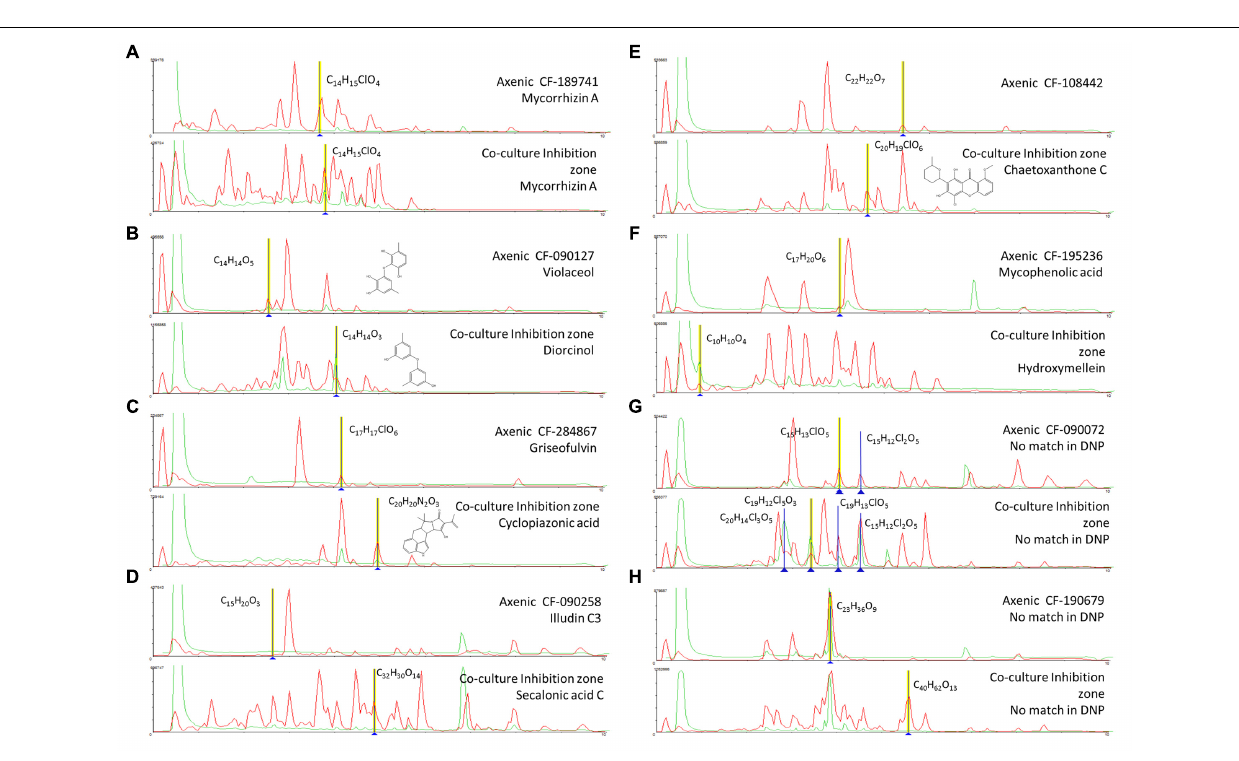
Frontiers in Microbiology |